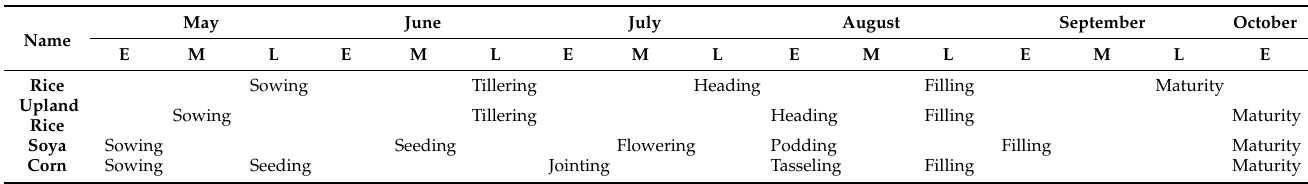
Table 1. The growth period of major crops in the study area. E means the early 10 days of a month, M is the middle 10 days, and L represents the later 10